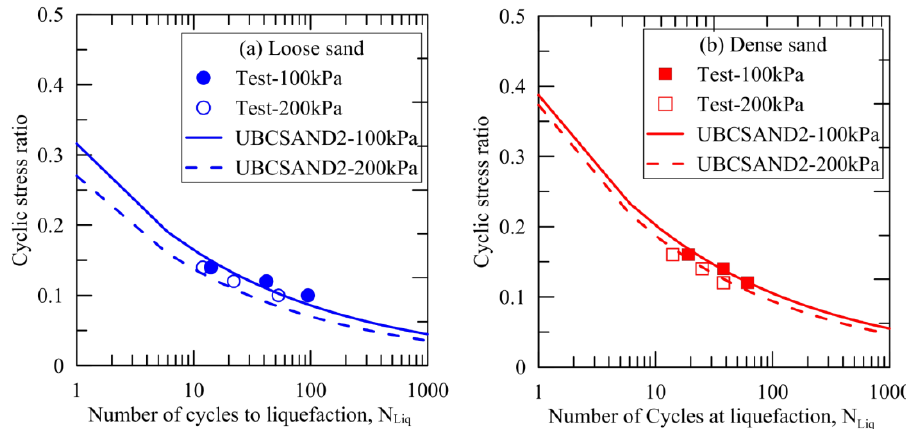
Figure 9. CSR – N liq curves obtained from the UBCSAND2 model for Pohang sand and laboratory CDSS tests.